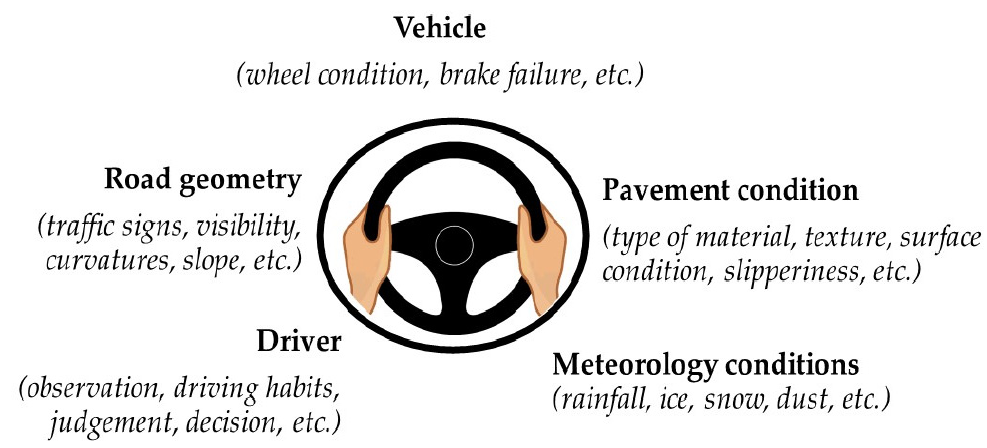
Figure 1. Components of safe driving.